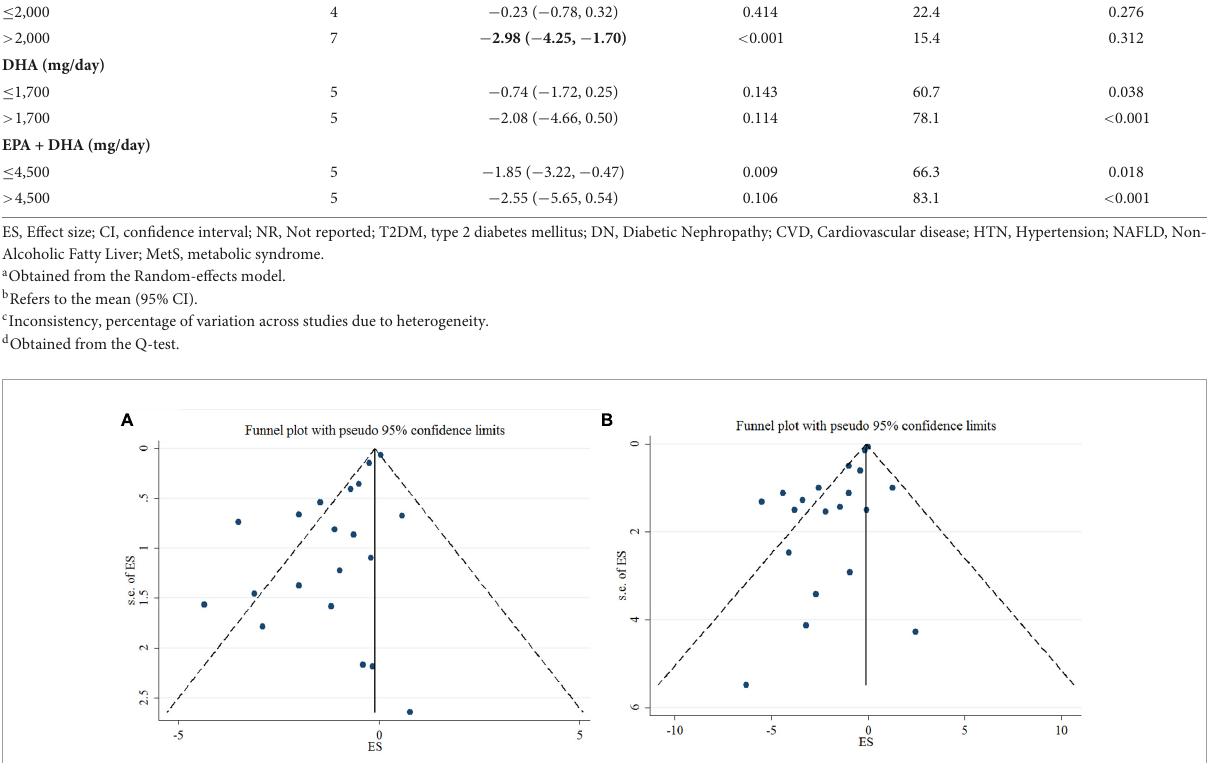
FIGURE3 Mean difference and 95% CIs presented in funnel plots; and publication bias of the studies the effects of n-3 PUFA supplementation on DBP (A) , and SBP (B)